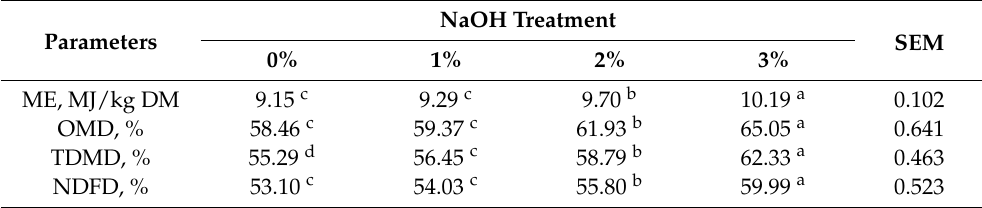
Table 2. Effects of NaOH treatment on the metabolizable energy and digestibility of reed straws. Parameters